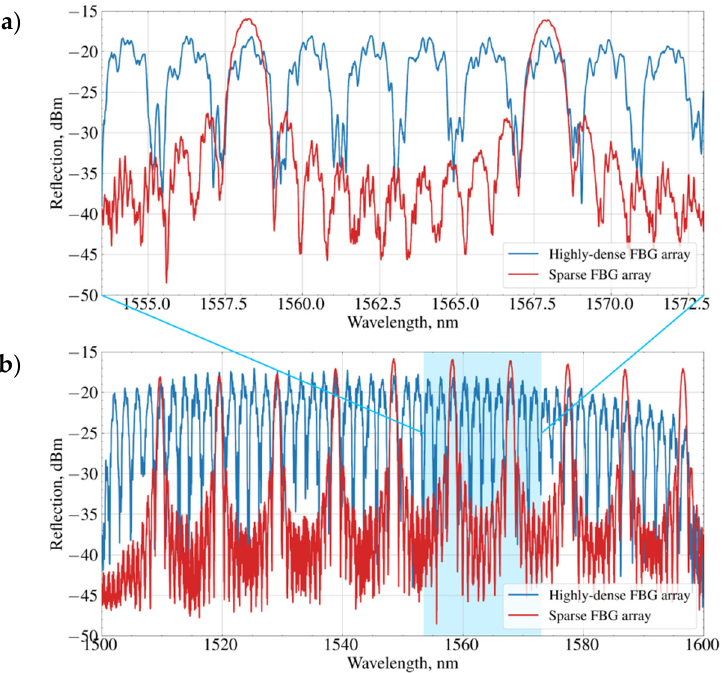
Figure 2. Reflection spectra of a highly dense and one of the sparse FBG sensors: zoomed ( a ) and full (b) spectral ranges.